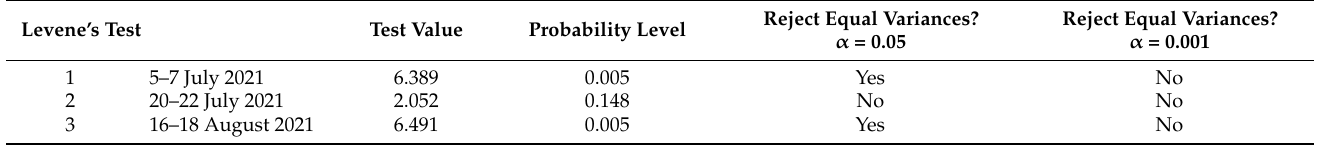
Table 2. The analysis of data variance applied on different data sets of treatments (groups) and evaluation time intervals at significance level 0.05 and